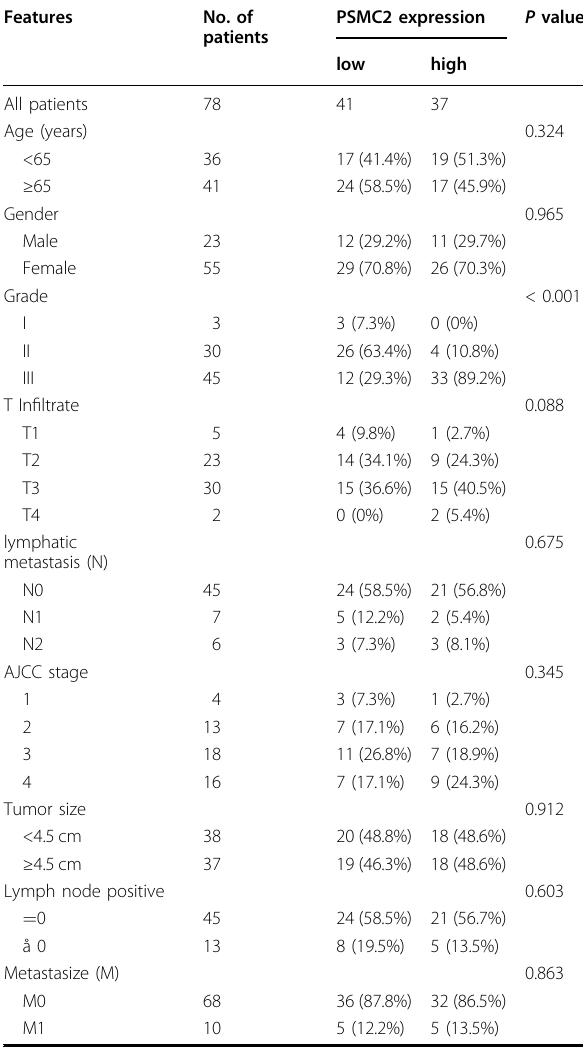
Table 2 Relationship between PSMC2 expression and tumor characteristics in patients with gallbladder